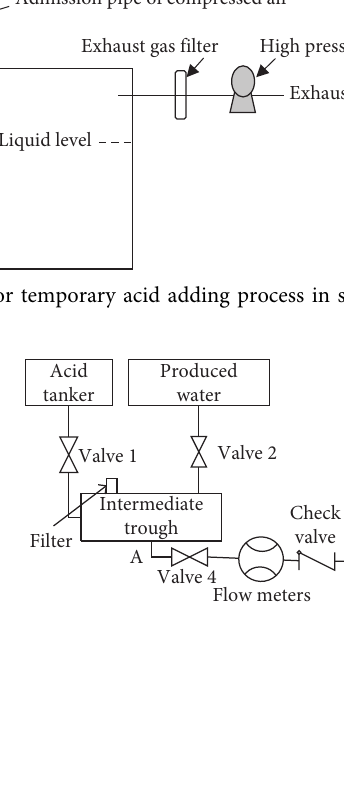
Figure 6: Schematic diagram of improving acid adding system for high-discharge waste